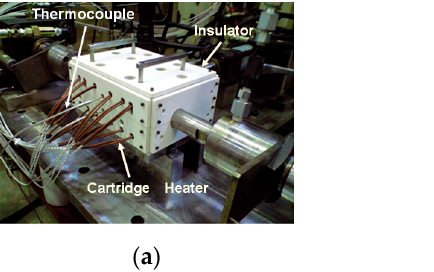
Figure 3. Configuration of a hydraulic circuit and its closed loop control system in WTHF.